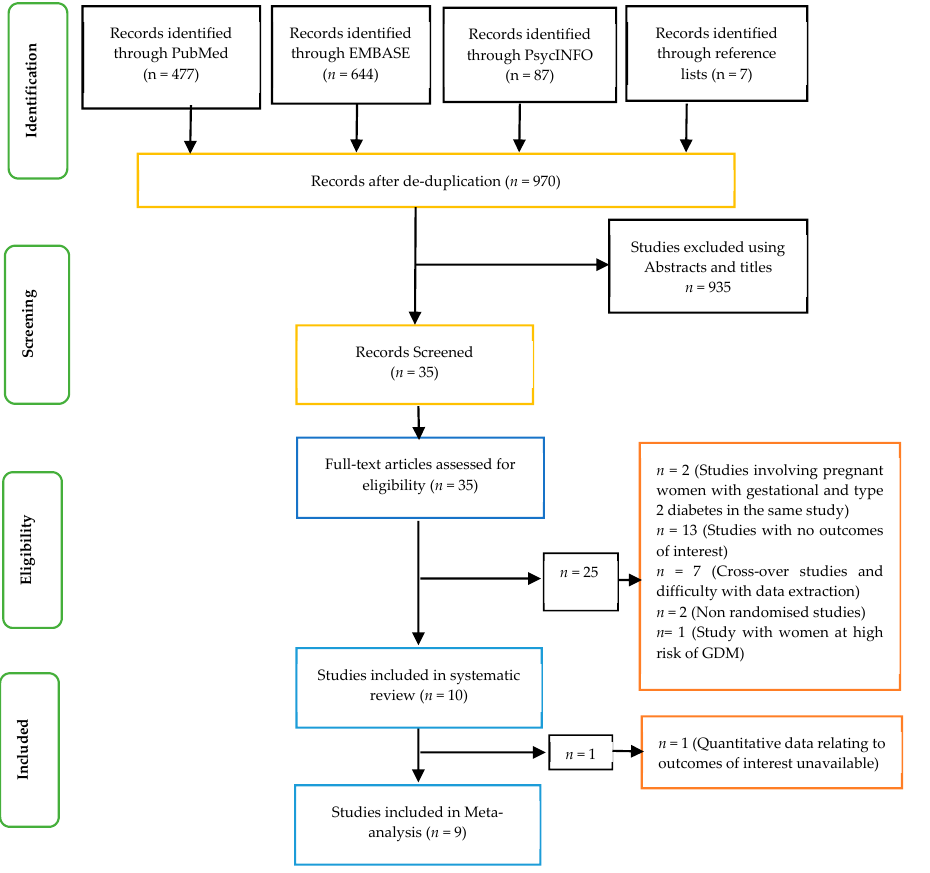
Figure 1. Prisma flow chart showing the studies included.